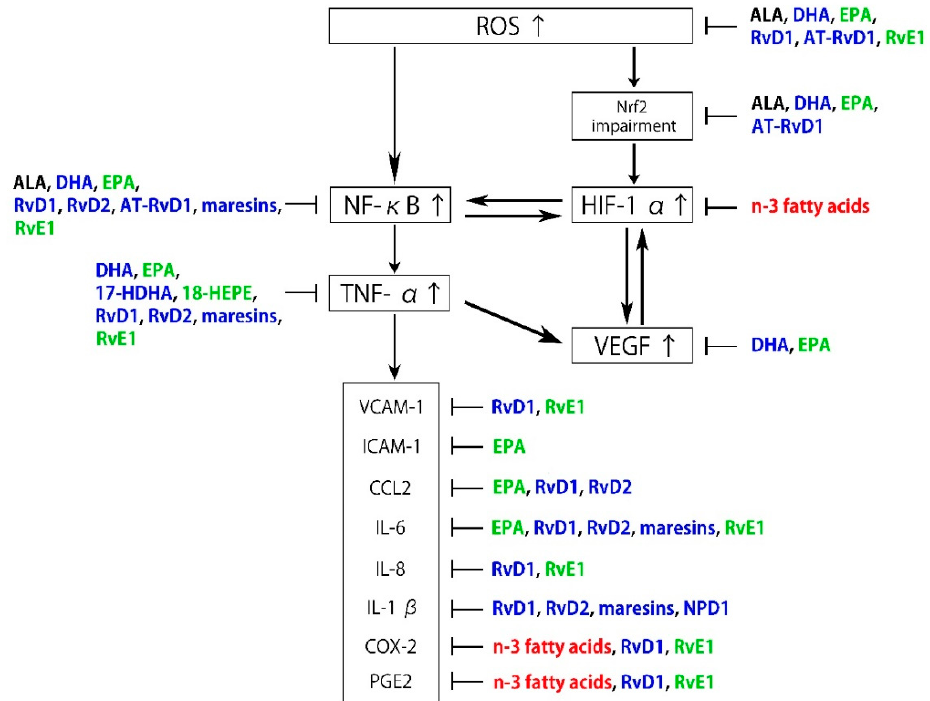
Figure 2. Schematic representation of the inhibitory effects of n-3 fatty acids and specialized proresolving mediator (SPM) on reactive oxygen species (ROS) and inflammation. Black: α -linolenic acid (ALA), Blue: docosahexaenoic acid (DHA) and its metabolites, Green: eicosapentaenoic acid (EPA) and its metabolites, Red: n-3 fatty acids.